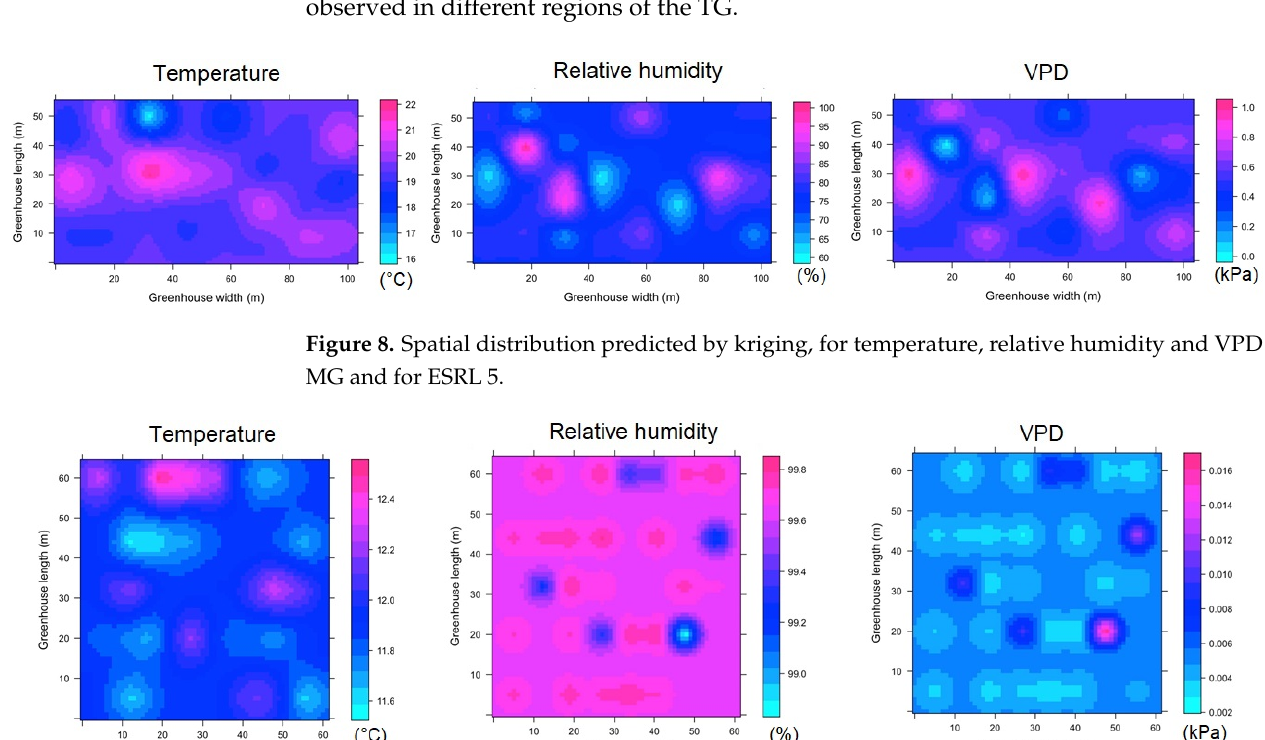
Figure 7. Spatial distribution predicted by kriging, for temperature, relative humidity and VPD in MG and for ESRL 1.